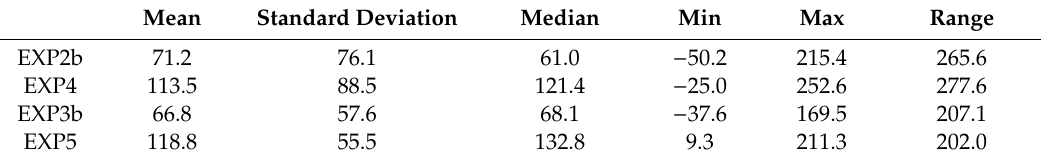
Table 13. RNET (W m − 2 ) simulated by UTOPIA and NOAH, initialized with GLDAS, at the CO station. Mean Standard Deviation Median Min Max Range